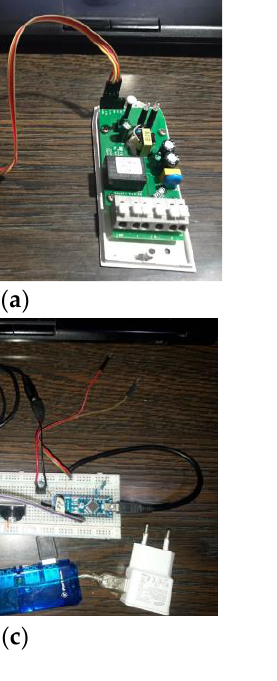
Figure A1. Setup of sensors and measuring devices: ( a ) smart plug device; ( b ) pzem-004t-100a module for total power consumption; ( c ) monitoring the PV system; and ( d ) Dragino LAQ4 for indoor environmental data.